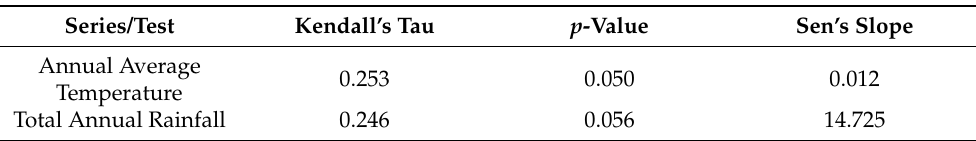
Table 6. The summary test results of Mann–Kendall and Sen’s slope test for annual average tempera- ture and total annual rainfall time